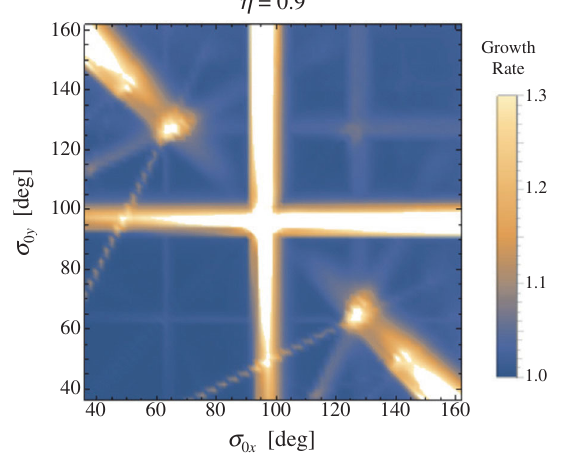
FIG. 13. Tune diagram obtained form 2D W ARP simulations at η ¼ 0 . 9 with no external nonlinearities. The rates of rms emittance growth numerically evaluated at about 5,000 different operating points are color-coded on the tune diagram. The horizontal and vertical rms emittances are initially unequal almost everywhere on the diagram because the tune depressions in both directions have been adjusted to the same value ( η x ¼ η y ¼ 0 . 9 ). degrees of freedom, we took the larger one of the two growth rates to choose the color. Each simulation is started with a thermally equilibrated beam confined by the sinusoidal focusing potential. The transport channel is 100 sinusoidal periods long. As explained in Sec. II B, the very small emittance growth along the lines σ 0 x ð 0 y Þ ≈ 60 ° is most likely due to the sixth-order resonance preceding the sextupole instability. The third-order resonance lines σ 0 x ð 0 y Þ ≈ 120 ° are not so clear as in Fig. 10 because of the absence of nonlinear error